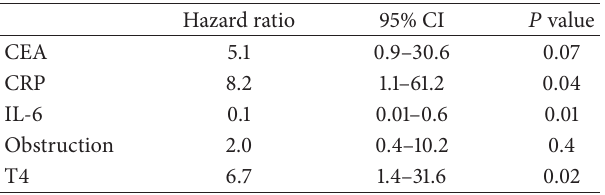
Table 4: Results of the multivariate Cox hazard model for disease- free survival in stage II colorectal patients ( 𝑛 = 60